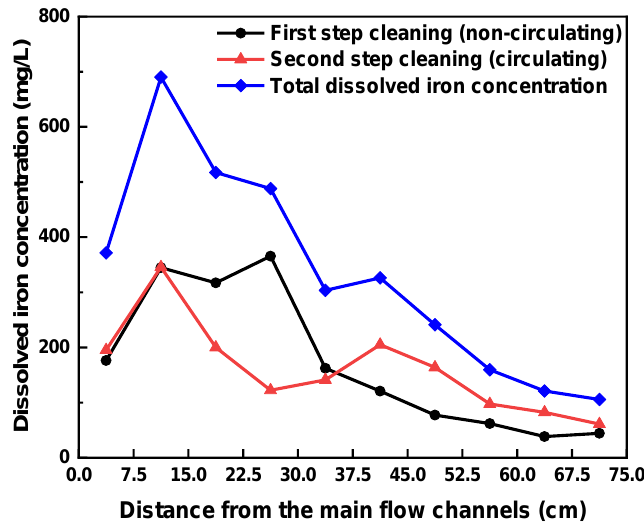
Figure 10. Iron concentrations dissolved from the main flow channels during the two-step cleaning process.